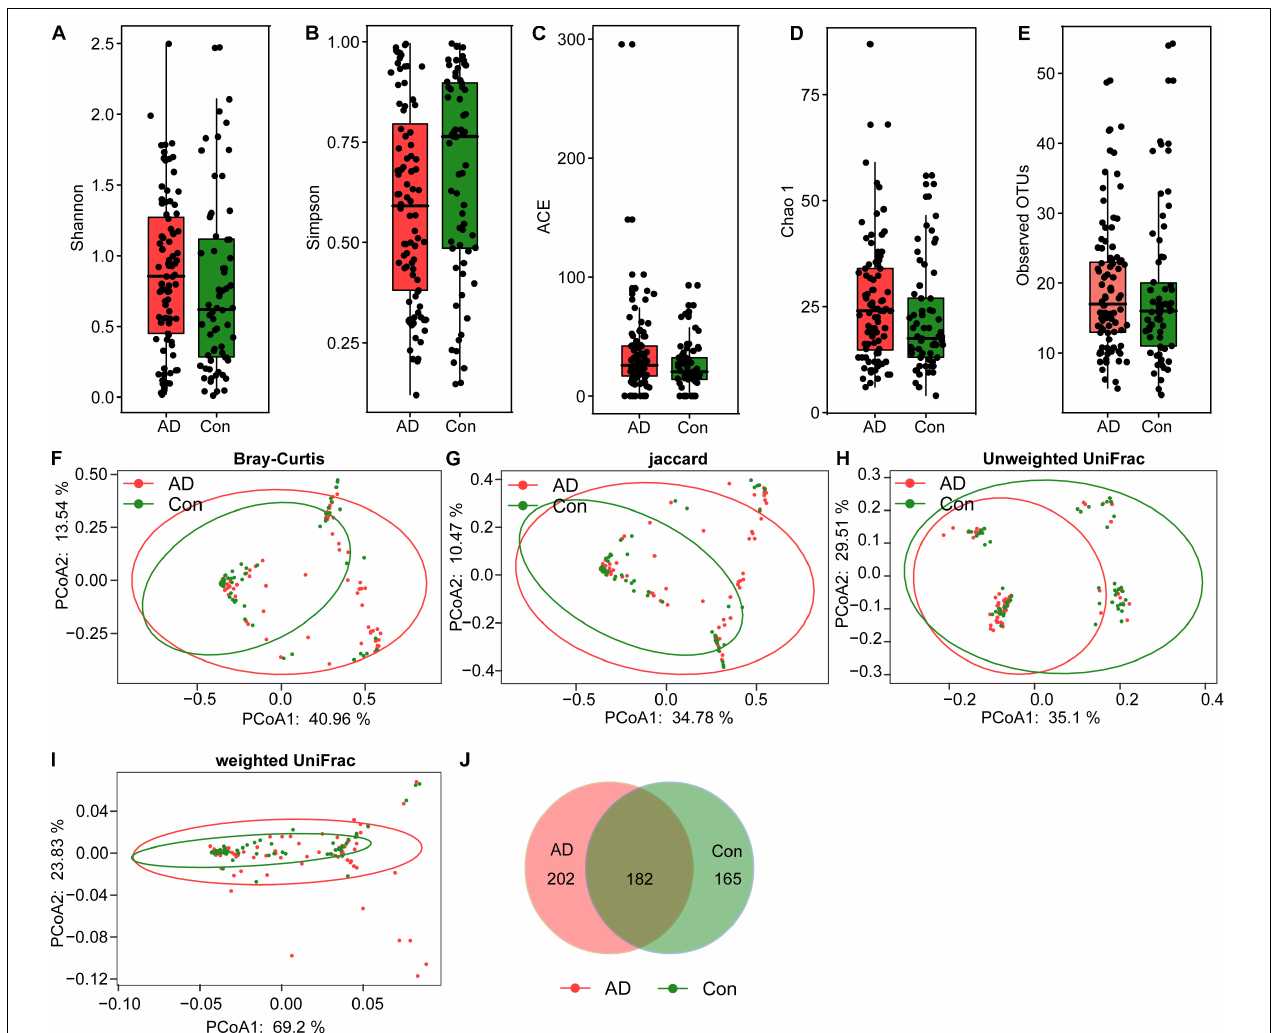
FIGURE 1 | Fungal diversity and richness of the fecal microbiota in Chinese AD patients. The diversity indices of Shannon (A) and Simpson (B) , and the richness indices of the observed species (C) , ACE (D) , and Chao1 (E) were used to evaluate the overall structure of the fungal microbiota in the stable AD patients and the healthy controls. The data are presented as mean ± standard deviation. Unpaired t -tests (two tailed) were used to analyze the variation between the groups. Principal coordinate analysis (PCoA) plots of individual fungal microbiota based on Bray–Curtis (F) , Jaccard (G) , and unweighted (H) and weighted (I) UniFrac distances in the AD patients and the healthy controls. Each symbol represents a sample. The Venn diagram illustrates the overlap of OTUs in the fungal microbiota between the two groups (J)